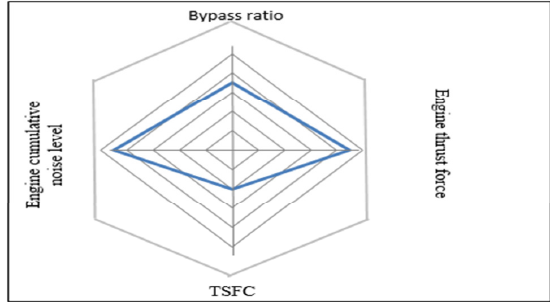
Fig. 3. Trent 772-60 optimum solution according to bypass ratio and engine thrust force.